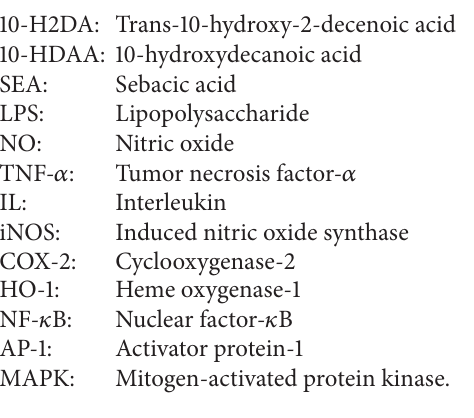
among the three FAs tested, suggesting a possible therapeutic potential against inflammatory